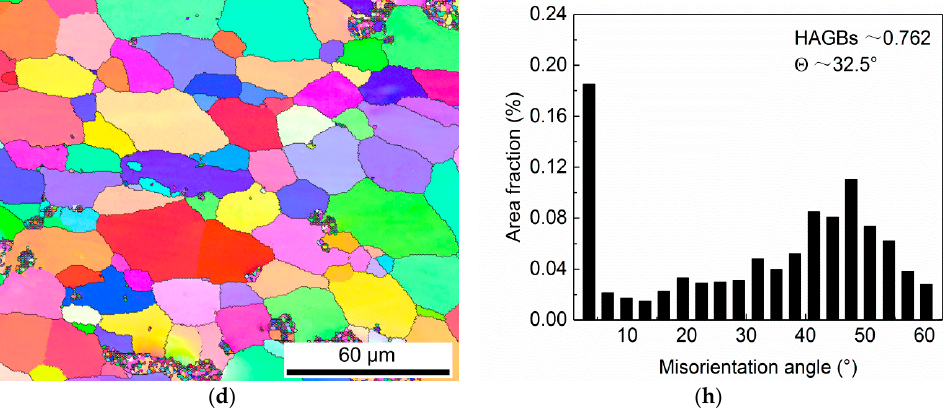
Figure 10. Influence of the temperature on the grain growth in the deformation process at 400 °C with . ε = 1 × 10 − 3 s − 1 , where the grain and orientation angle are shown in ( a , e ), as well as 450 °C in ( b , f ), 500 °C in ( c , g ), and 550 °C in ( d , h ).